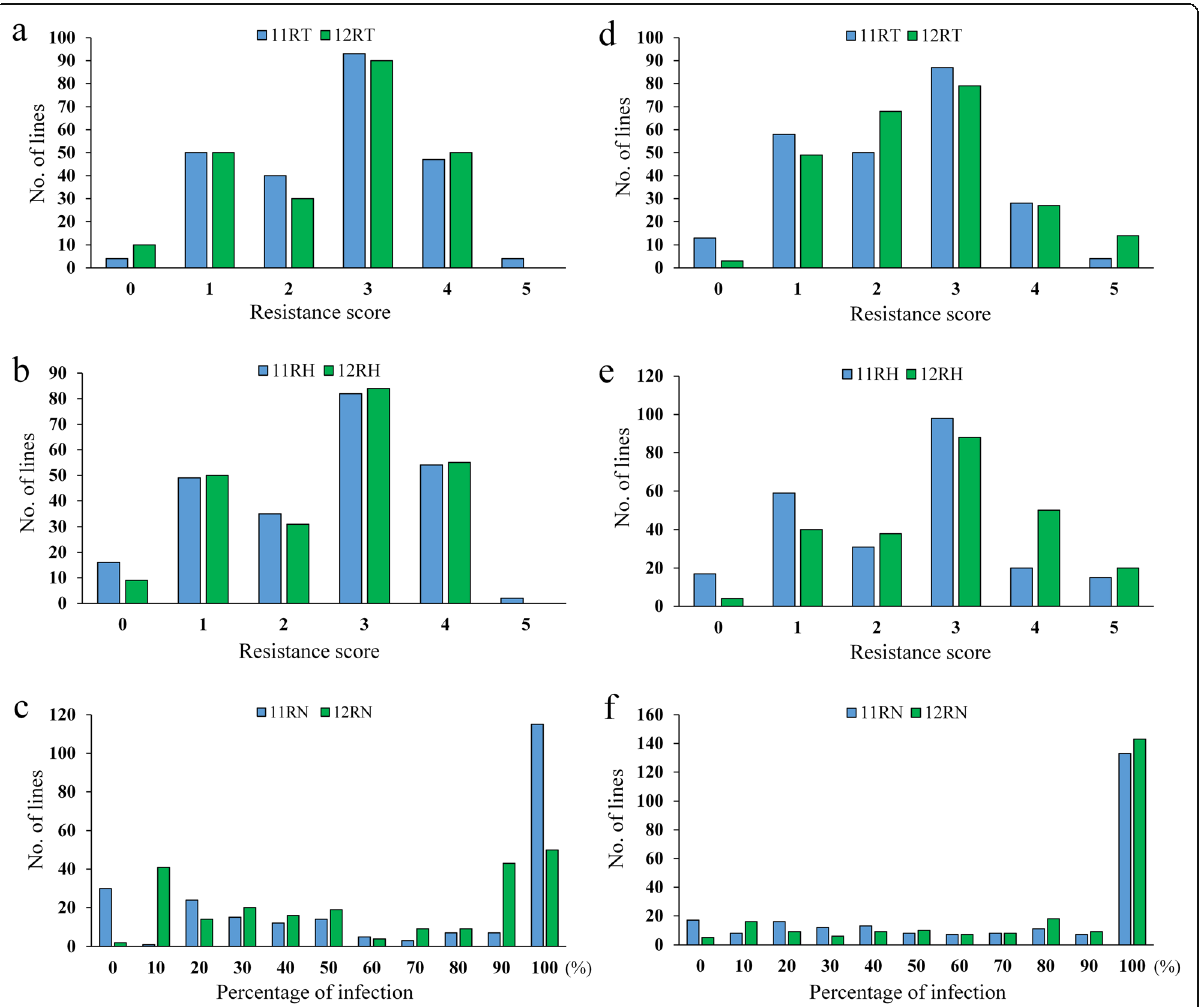
Fig. 2 Frequency distribution of blast resistance of the Jin23B/CR071 ( a , b , c ) and Jin23B/QingGuAi3 ( d , e f ) population in 2011 and 2012. 11RT and 12RT, leaf blast resistance at tillering stage in 2011 and 2012. 11RH and 12RH, leaf blast resistance at heading stage in 2011 and 2012. 11RN and 12RN, neck blast resistance at maturation stage in 2011 and 2012. Blue pillar and green pillar indicate the frequency of BC 3 F 1 and BC 3 F 2 population,